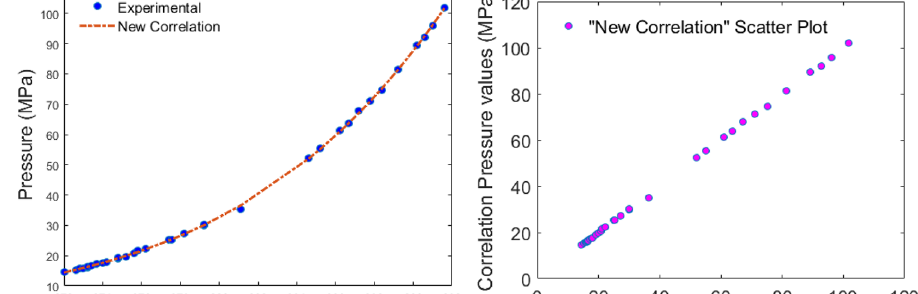
Table 15 Fractional cage occupancy comparison with results from Klauda and Sandler (2002, 2003), Cao et al. (2001a), and Sloan (1998) and experimental data of Sum et al. (1997)